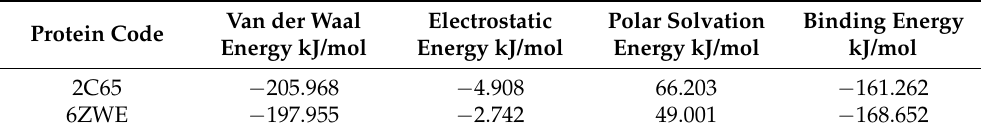
Table 3. MMPBSA results of Binding energy of 2C65 and 6ZWE. Van der Waal Electrostatic Protein Code Energy kJ/mol Energy